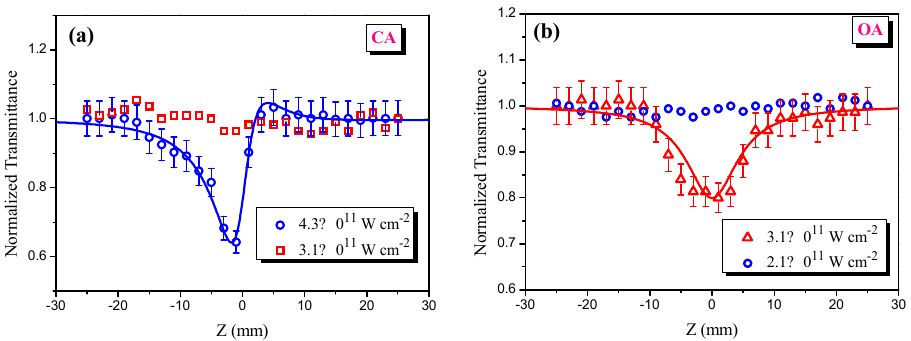
Figure 5. ( a ) CA and ( b ) OA Z − scan curves of the thin film mixed perovskite at 1030 nm wavelength laser pulses. In the case of CA, the intensity of the probing laser beam was ~4.3 × 10 11 W·cm − 2 , where self-focusing effect (blue open circles) was observed. For probing beam with intensity ~3.1 × 10 11 W·cm − 2 , the normalized transmittance did not change (red open squares). In the case of OA, the intensity of the probing laser beam was 3.1 × 10 11 W·cm − 2 , where TPA effect (red open triangles) was obtained. The normalized transmittance (blue open circles) did not change at the intensity of 1.2 × 10 11 W·cm − 2 of probing laser beam.